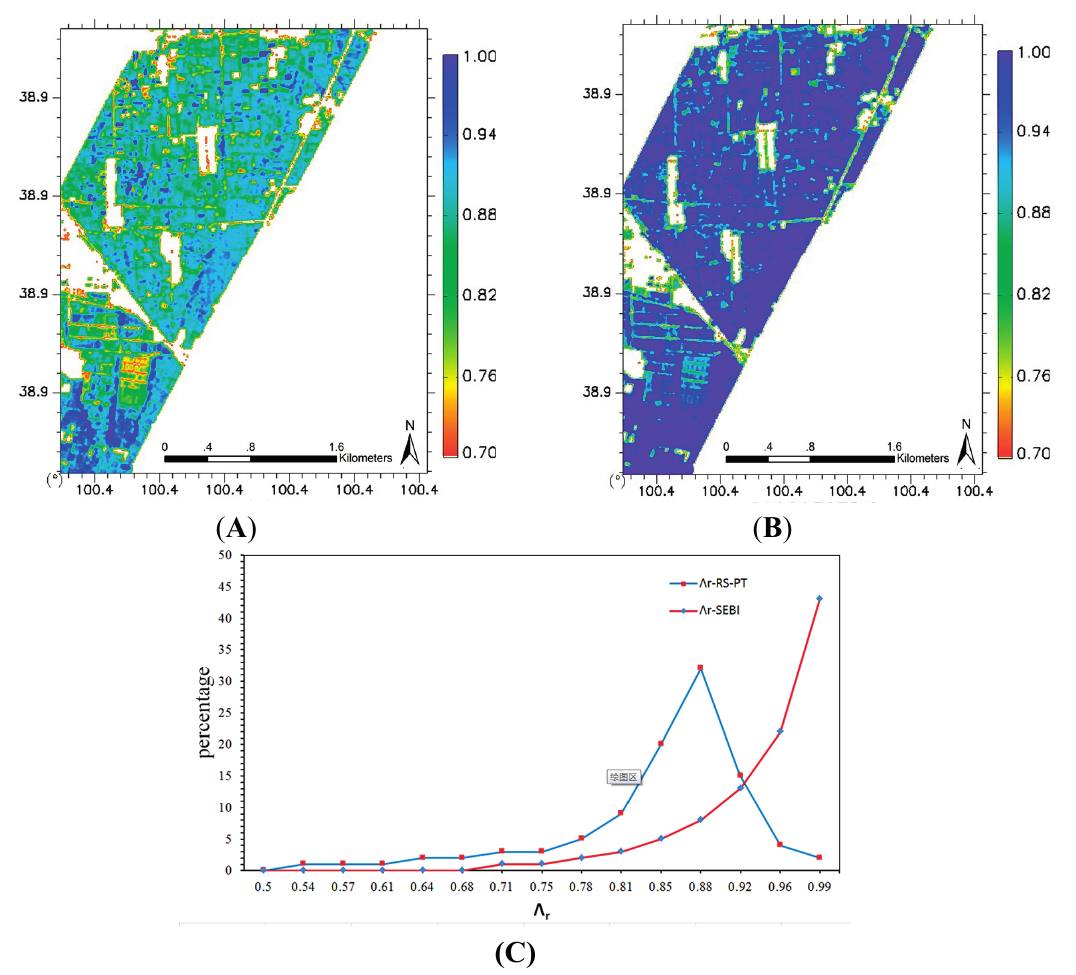
Figure 11. The spatial pattern and frequency curves of Λ r from different methods using WiDAS data over Zhangye Oasis on 7 July 2008: ( A ) Λ r is obtained using the LST-Fc feature-space ( Λ r _RS-PT); ( B ) Λ r _SEBI is obtained based on SEBI ( Λ r -SEBI); and ( C ) the frequency curves of (A) and